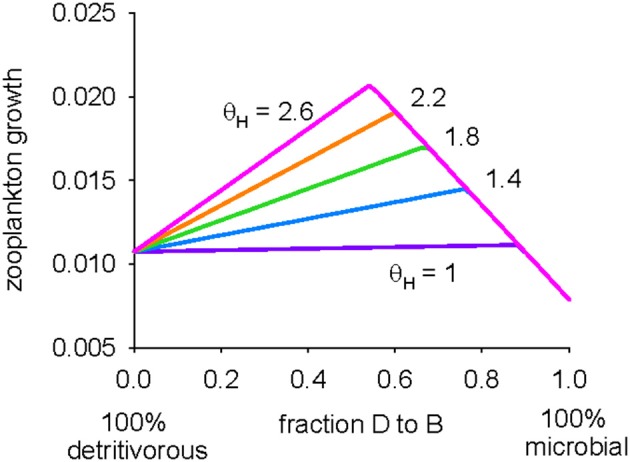
Predicted zooplankton growth for 0 (pure detritivorous) ≤ ψB ≤ 1 (pure microbial pathway) and θH (DHA:C ratio in protistan bacterivores) between 1.0 and 2.6 mmol mol−1.